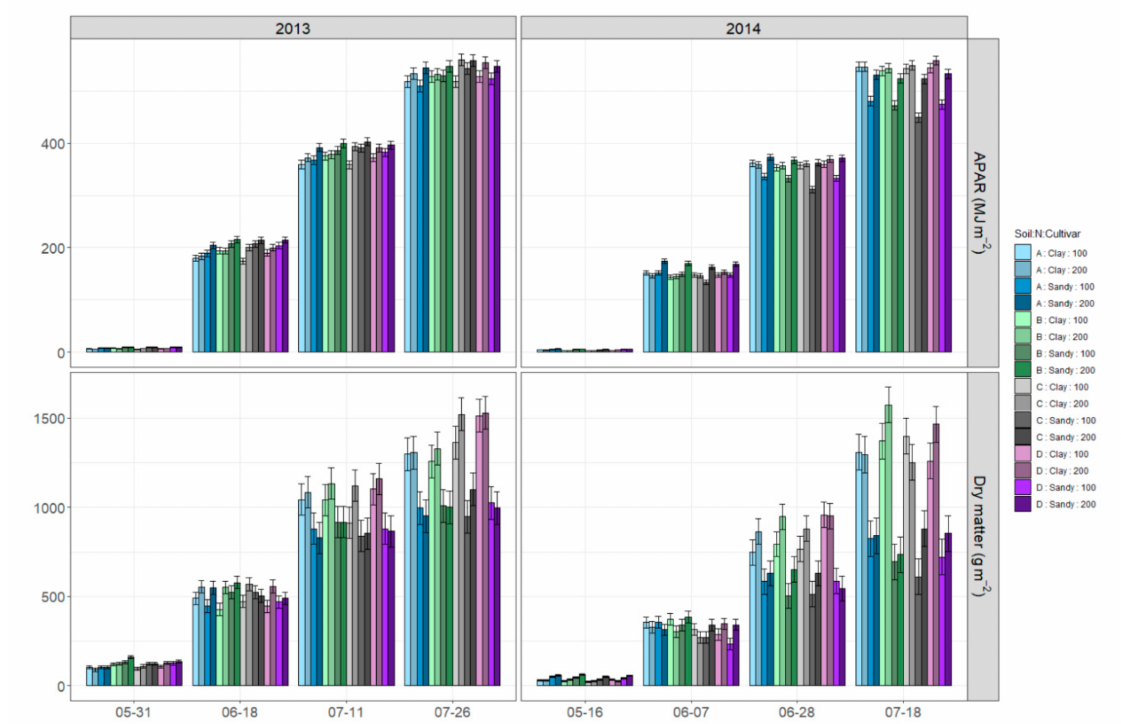
Figure 2. Estimated mean accumulated intercepted photosynthetic active radiation (APAR) and aboveground dry matter (DM) of the two soil types, four varieties and two nitrogen levels for each time point in 2013 ( left ) and 2014 ( right ). Error bars represent standard error of the means. A, B, C, D denote the spring wheat varieties Quintus, Scirocco, Økilde and Hovsa, respectively. Across the two years, DM and GY at final harvest were significantly a ff ected by soil type and − 1 − 1 N level and being higher on clay than on sandy and with 200 kg N ha than with 100 kg N ha (Table 2). On the clay soil, the Hovsa cultivar (D) had the highest GY and DM under both N-fertilization − 1 levels. On clay soil with 100 kg N ha , the cultivar Hovsa possessed significantly greater GY and DM − 1 than Scirocco (B); while under 200 kg N ha , the cultivar Quinus (A) had the lowest GY, which was significantly lower than that of